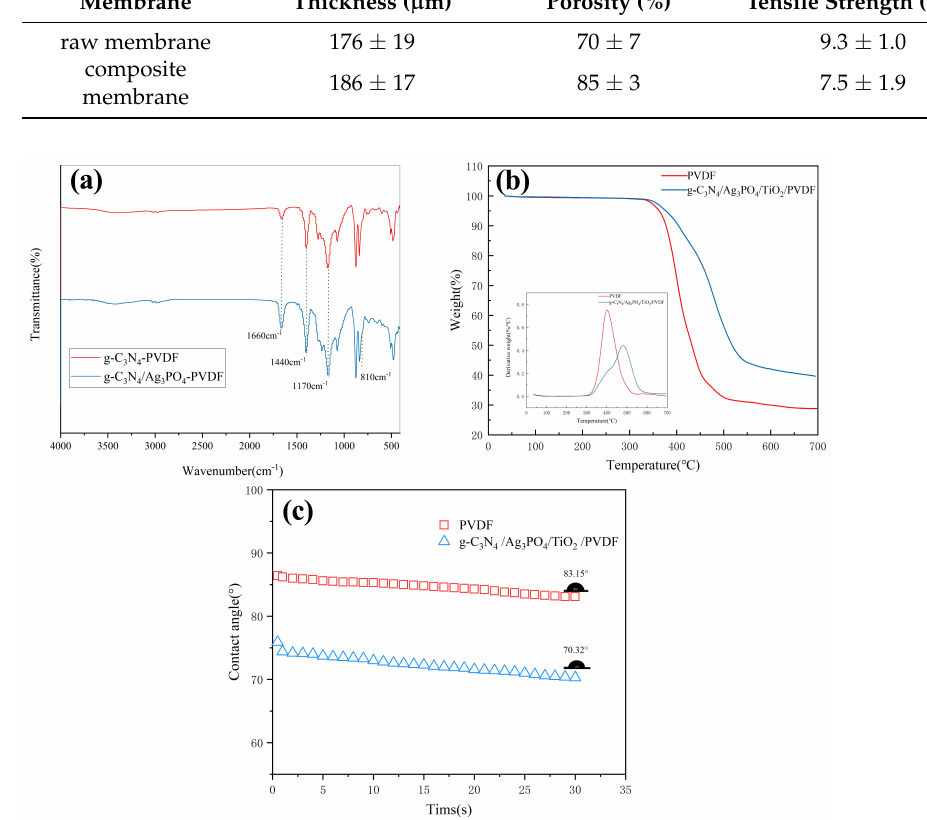
Table 1. Characteristics of different membranes.